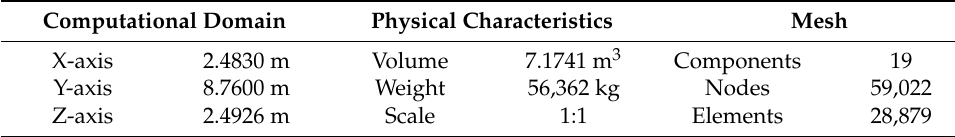
Figure 3. Finite element model of the Shafting system. Table 4. Shafting geometry, physics, and